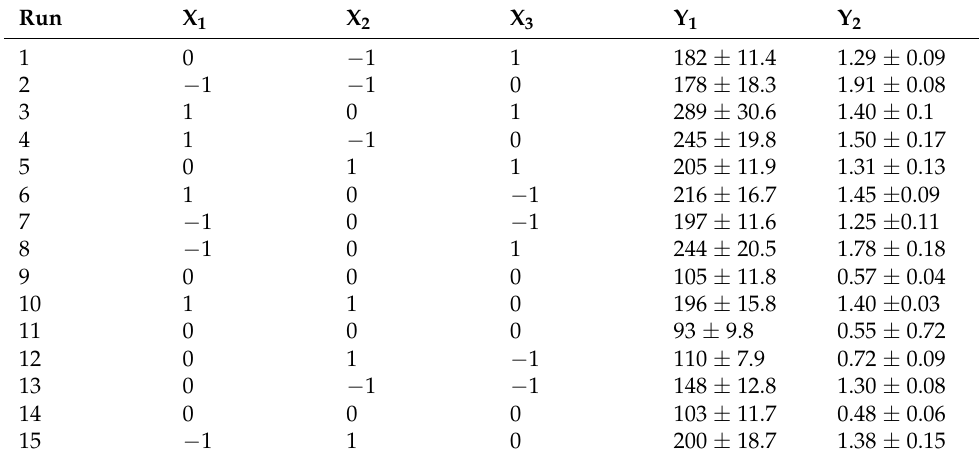
Table 2. Results of randomized experiments of the Box–Behnken design. Run X 1 X